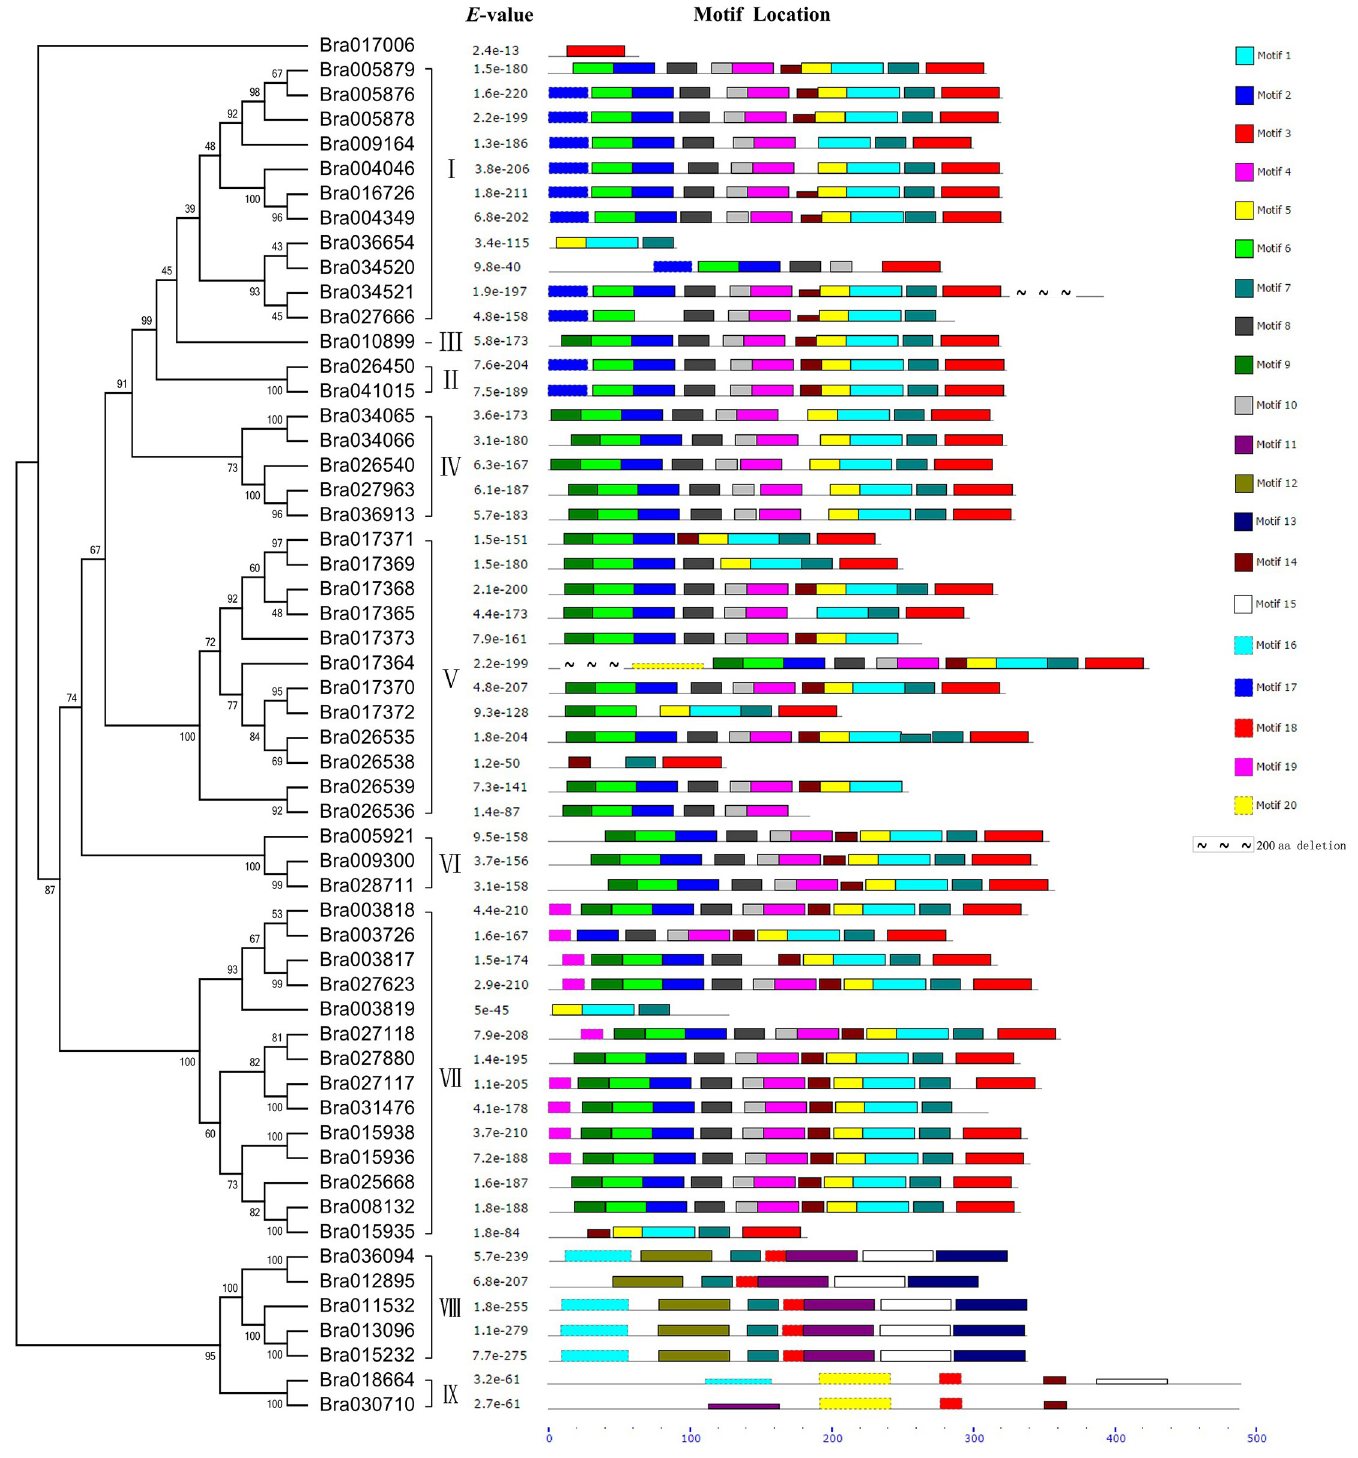
Fig 5. Conserved motifs of BraSOT proteins. Phylogenetic relationships, SOT groups, E-values, and locations of motifs in BraSOT domain sequences are shown. Values above and below branches in the tree are bootstrap percentages. Motifs are represented by the colors shown in the legend on the right. Motifs 2 and 3 include regions I and region IV, respectively. The height of a block indicates the significance of the match, as taller blocks are more significant.